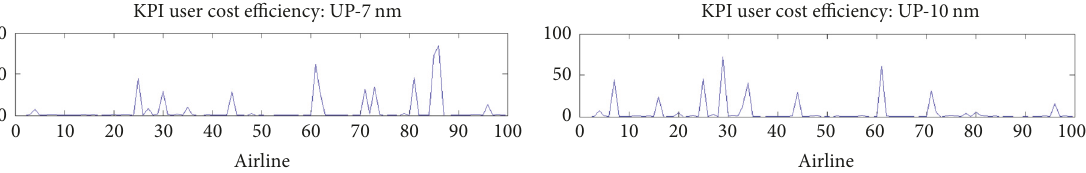
Figure 12: User cost efficiency (Kg/flight) in analysis cases 7NM/100-AUs/CI in [0,400] versus 10NM/100-AUs/CI in [0, 400] .